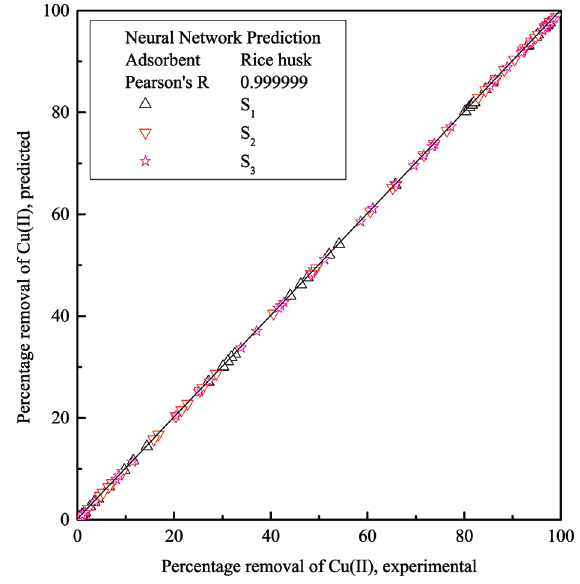
Figure 11. Neural network comparison